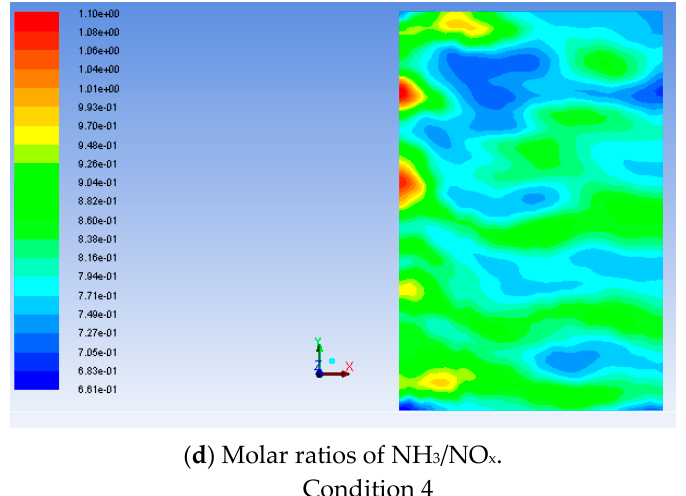
( d ) Molar ratios of NH 3 /NO x . Figure 8. Distribution characteristics of NH 3 /NOx on the 500 mm section upstream of the catalyst first layer. ( a ) Condition 1; ( b ) Condition 2; ( c ) Condition 3; ( d ) Condition 4.